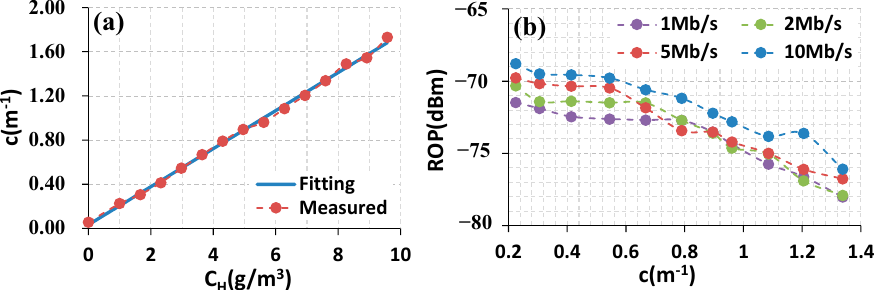
Figure 6. ( a ) Attenuation coefficient as a function of aluminum hydroxide concentration and ( b ) received optical power (ROP) under different water turbidities after 10 m underwater channel.